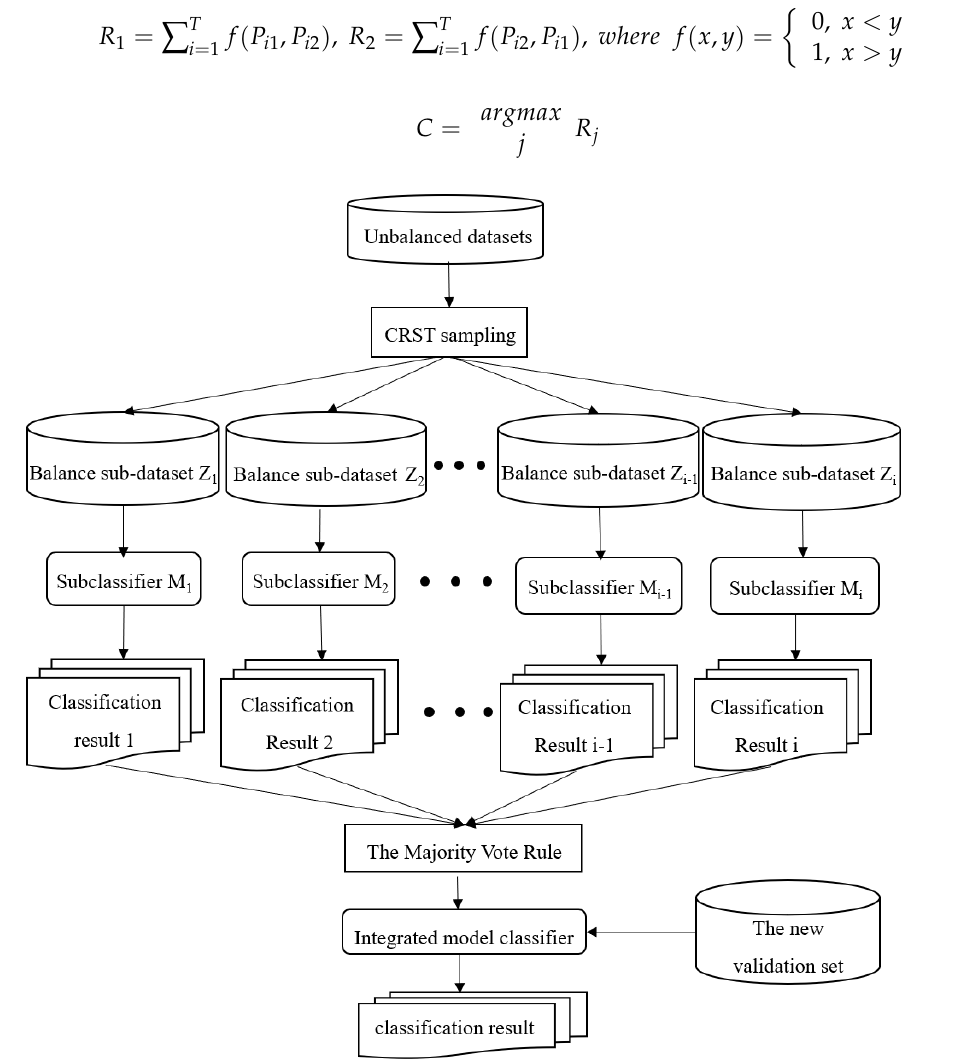
Figure 7. CRST-Bagging algorithm structure diagram.